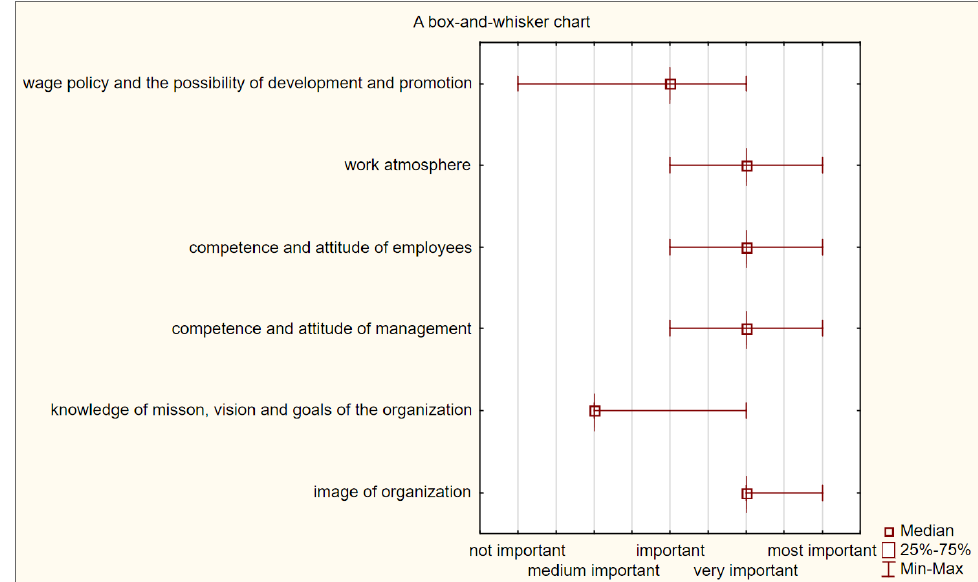
Figure 2. A box-and-whisker chart organizational trust by respondents.